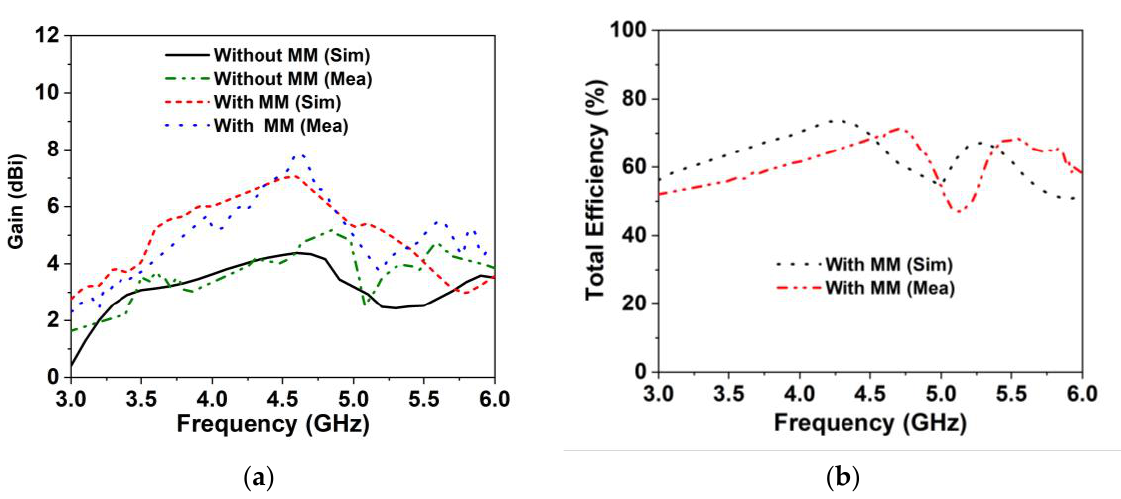
Figure 11. Measured and simulated ( a ) realized gain and ( b ) total efficiency for the developed wideband MIMO antenna.